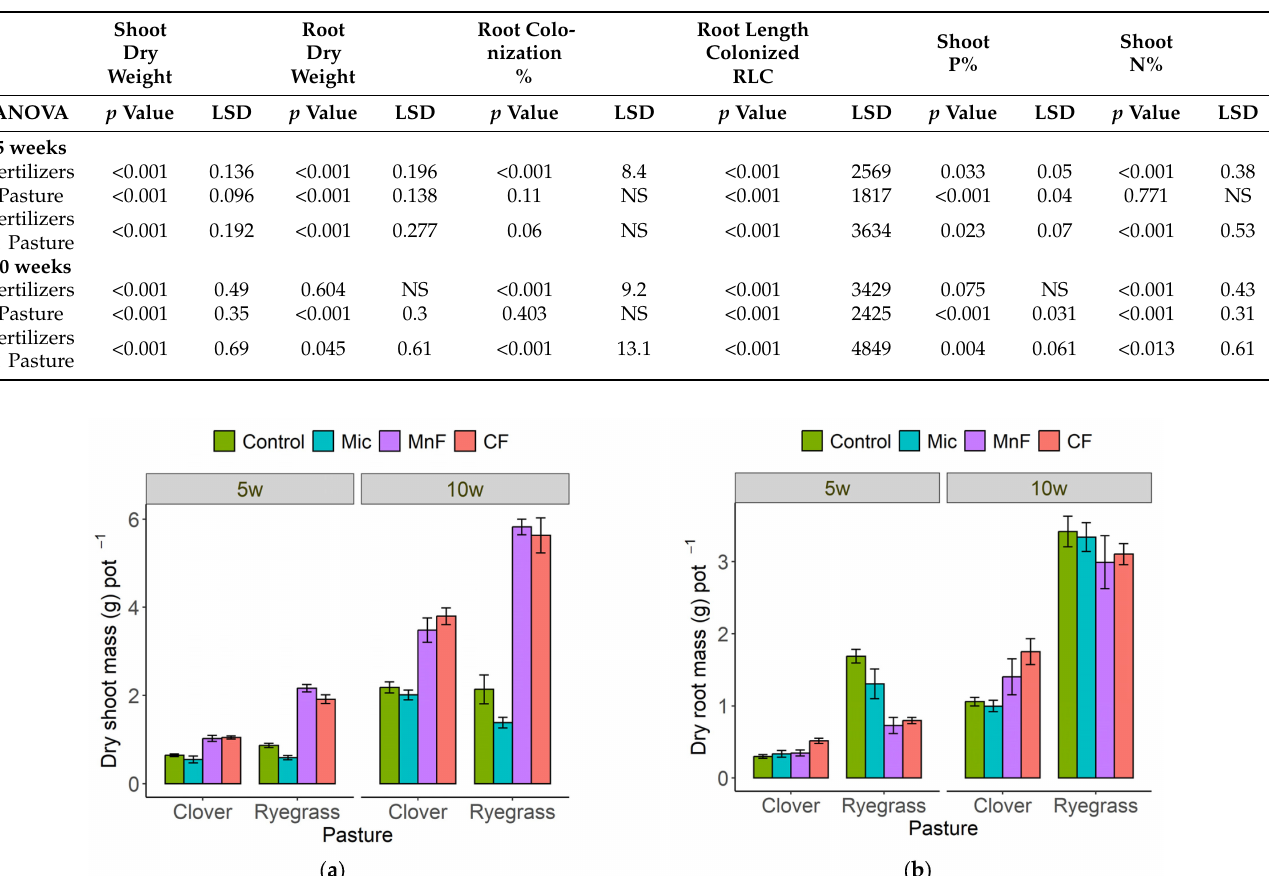
Table 1. ANOVA for shoot dry weight (g pot − 1 ), root dry weight, root colonization (%), root length colonized (RLC (m pot − 1 ), shoot P% and shoot N% at 5 and 10 weeks after sowing. LSD value given if p ≤ 0.05. NS = not significant.